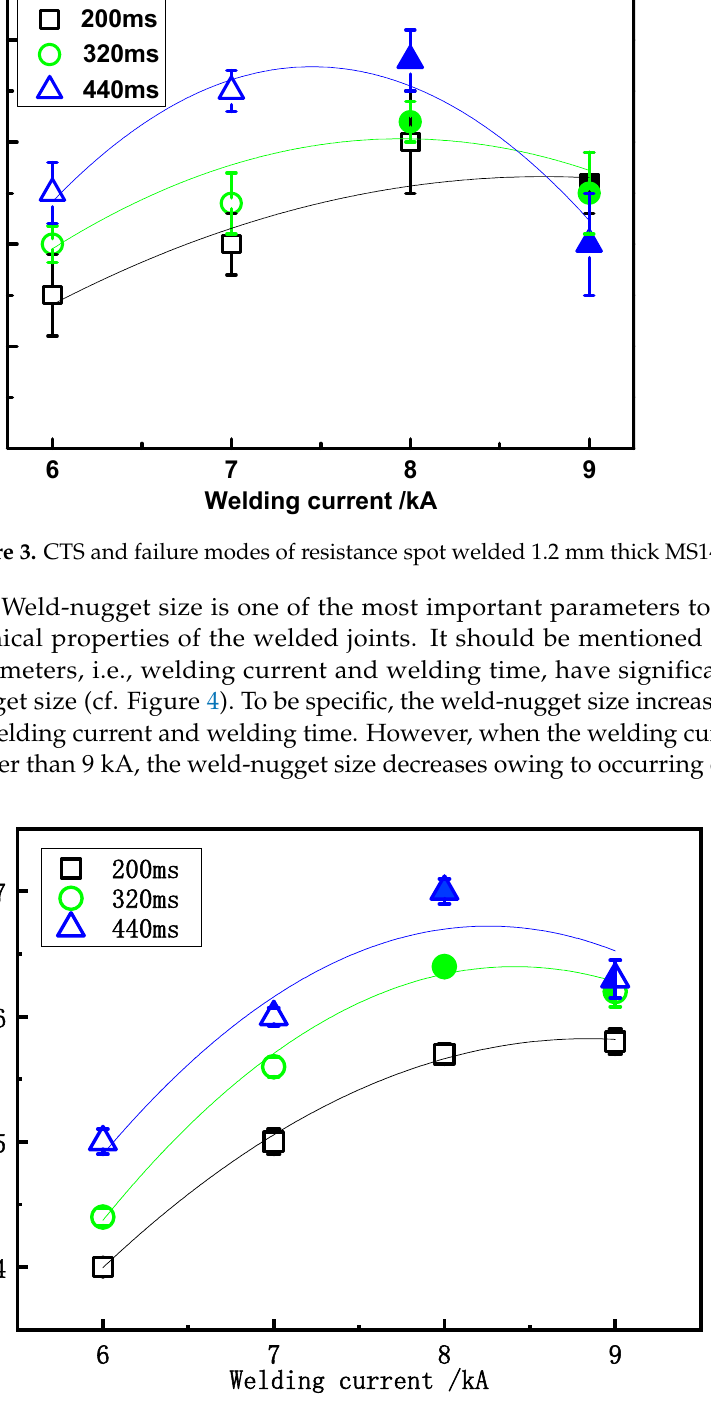
Figure 2. TSS and failure modes of resistance spot welded 1.2 mm thick MS1400 steel.